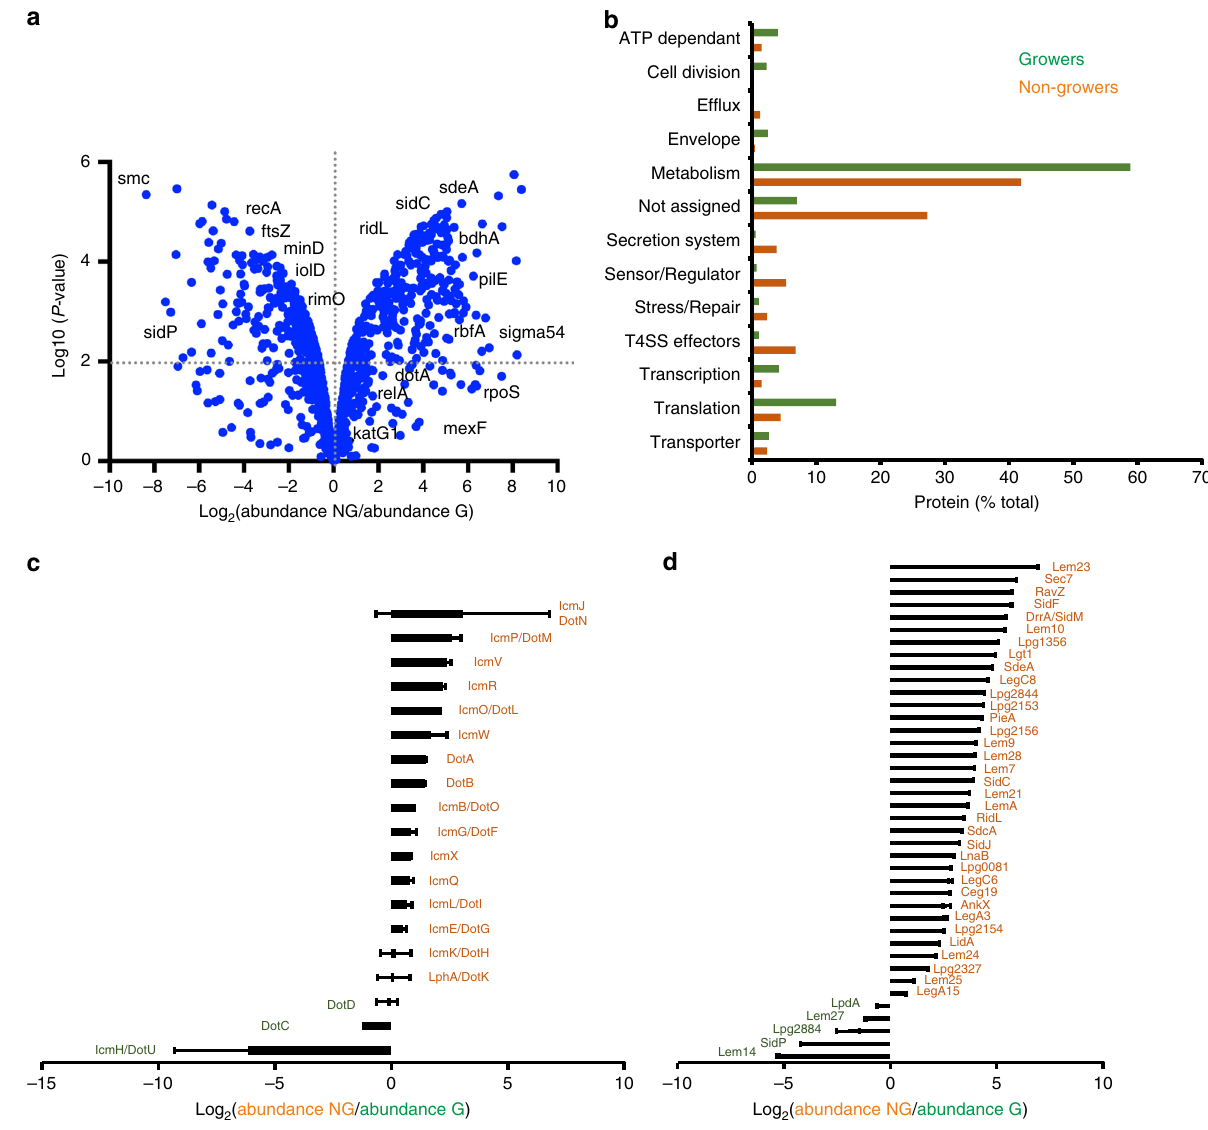
Fig. 3 Intracellular L. pneumophila subpopulations produce distinct proteomes. a A. castellanii amoebae were infected (MOI 1, 24 h) with L. pneumophila / Timer, lysed and the intracellular bacterial subpopulations FACS-sorted according to the Timer green/red color ratio. Comparative proteomics of sorted growers (G) and nongrowers (NG) revealed differentially produced proteins. Protein abundance in each subpopulation is depicted as volcano plot (see Supplementary Data 1 for the full dataset). b Functional classi fi cation of proteins identi fi ed in intracellular growing and nongrowing L. pneumophila subpopulations. The abundance of c Icm/Dot T4SS subunits and d Icm/Dot-translocated effector proteins are depicted. NG nongrowers, G growers. Data represent the mean ± SEM of four biological replicates ( n = 4) pooled into two to increase the number of peptides